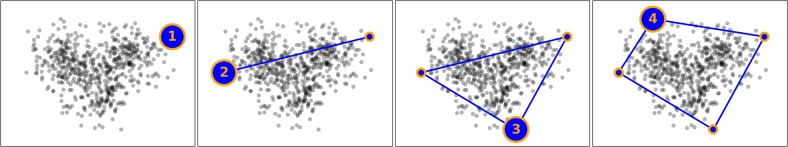
Example in which way Simplex Volume Maximization iteratively determines basis vectors for interpretable matrix factorization.